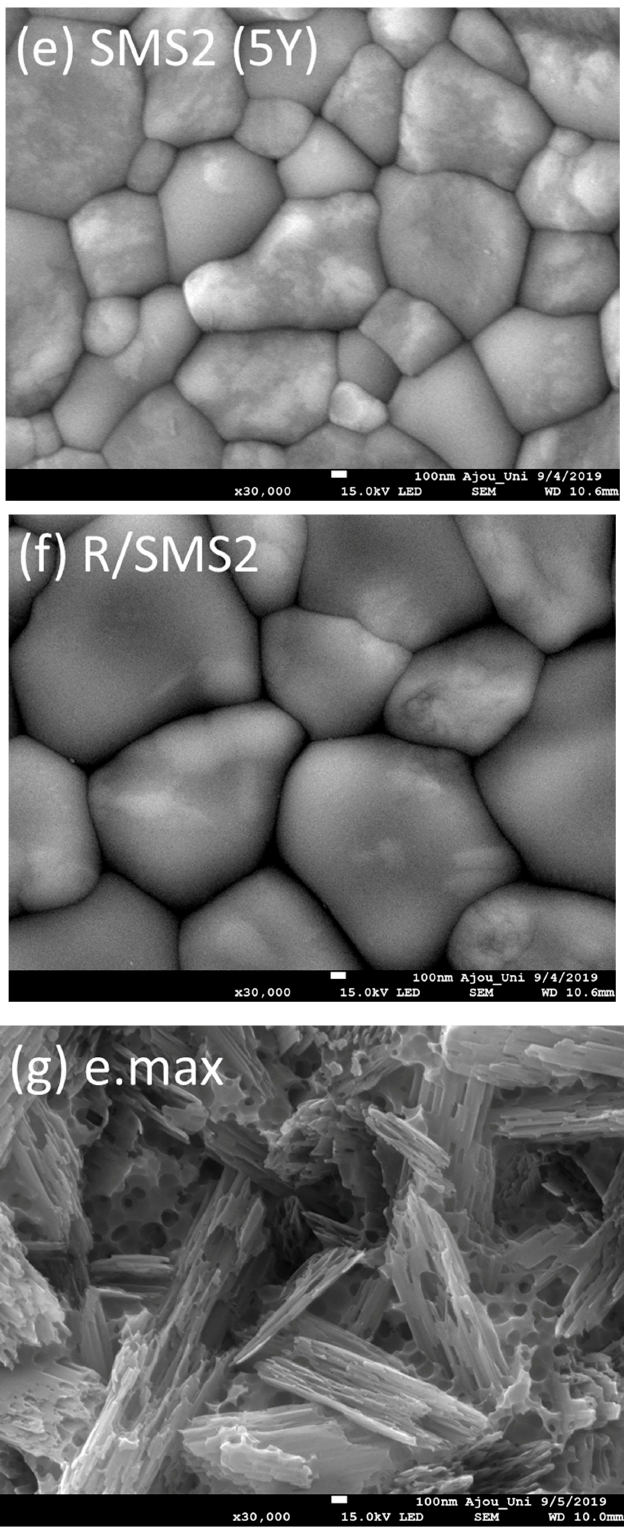
Figure 5. Scanning electron micrographs of the ceramic specimens investigated: ( a ) S2 (3Y), ( b ) R/S2, ( c ) E2 (4Y), ( d ) R/E2, ( e ) SMS2 (5Y), ( f ) R/SMS2, and ( g ) e.max.